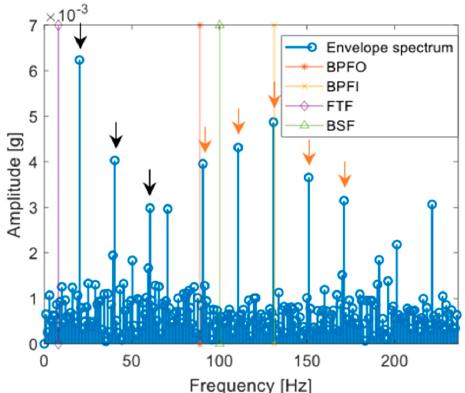
Figure 16. Frequency domain of envelope analysis.